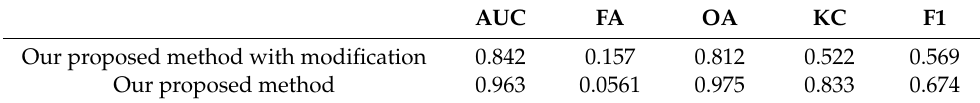
Table 6. The performance comparison for California to show the role of feature classification part. AUC FA F1 Our proposed method with modification